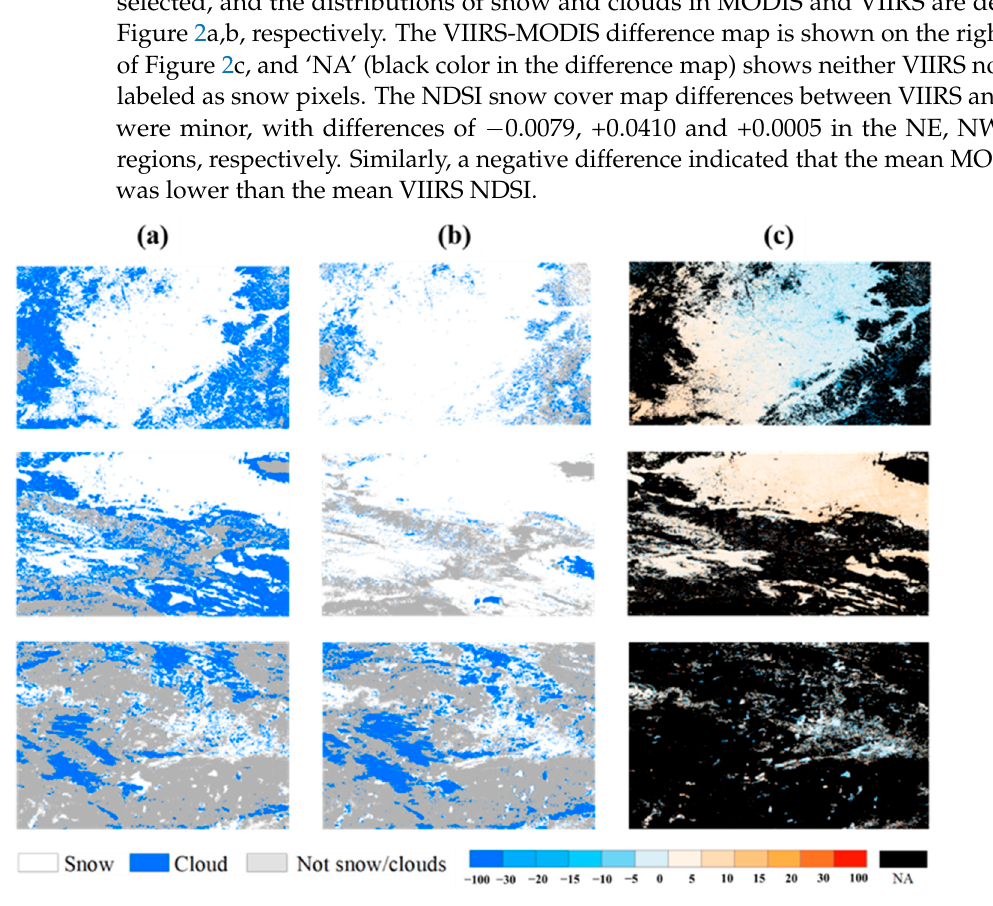
Figure 2. The distribution of snow and cloud cover in MODIS ( a ) and VIIRS ( b ). ( c ) NDSI difference (VIIRS minus MODIS); the values are scaled by 100 and ‘NA’, meaning ‘not available’, represents neither VIIRS nor MODIS labeled as snow pixels. The three test regions NE (2020002), NW (2020038) and QT (2020047) are shown from top to bottom, along with the day of the year (DOY).